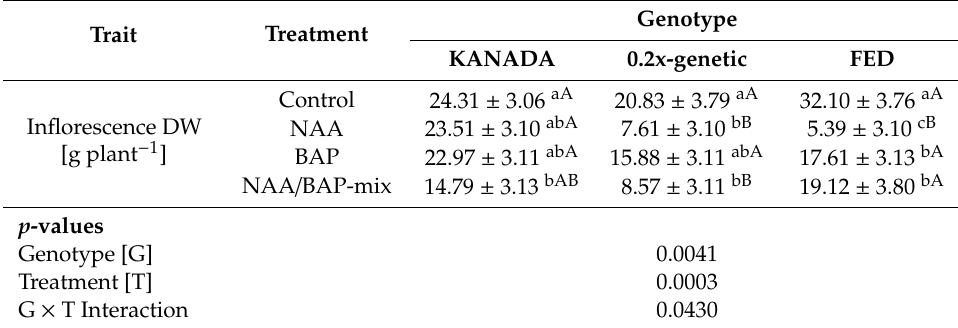
Table 1. Mean inflorescence dry weight (DW) in g plant − 1 of genotypes KANADA, 0.2x-genetic, and FED, treated with NAA, BAP, and NAA / BAP-mix and a nontreated control. Results are presented as mean values ± standard error of mean (mean ± SEM). Means of treatments in one column followed by at least one identical lowercase letter are not significantly di ff erent, as indicated by the LSD test ( α = 0.05). Means of genotypes in one row followed by at least one identical uppercase letter are not significantly di ff erent, as indicated by the LSD test ( α = 0.05). The p -values correspond to global F tests for di ff erences between the levels of the mentioned genotypes, treatments, or their interactions. Genotype Trait Treatment